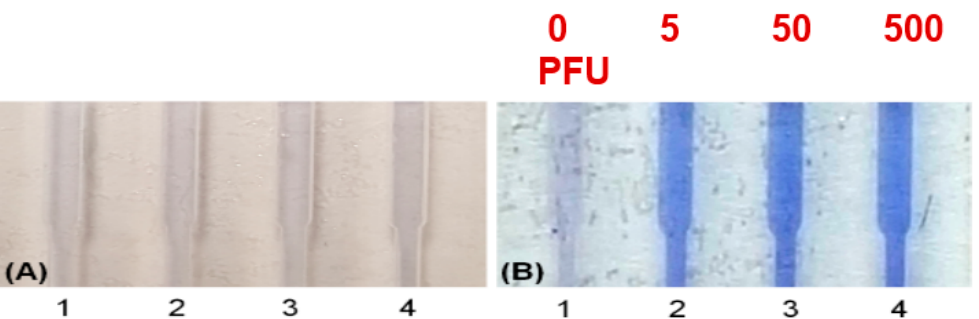
Figure 7. Colorimetric detection reporter for chip-based isothermal amplification. Leuco crystal violet (LCV) changes from colorless to violet in the presence of dsDNA, and offers a simpler visual alternative to fluorescence detection, removing the need for an excitation light, a detector, and filters. Amplification chambers loaded with LCV dye: Starting template concentrations: 0 (NTC, no template control), 5, 50, and 500 PFU (plaque forming units). ( A ) at start of amplification; ( B ) after 40 min. Positive tests exhibit a distinct violet color due to amplicon production. From [103].